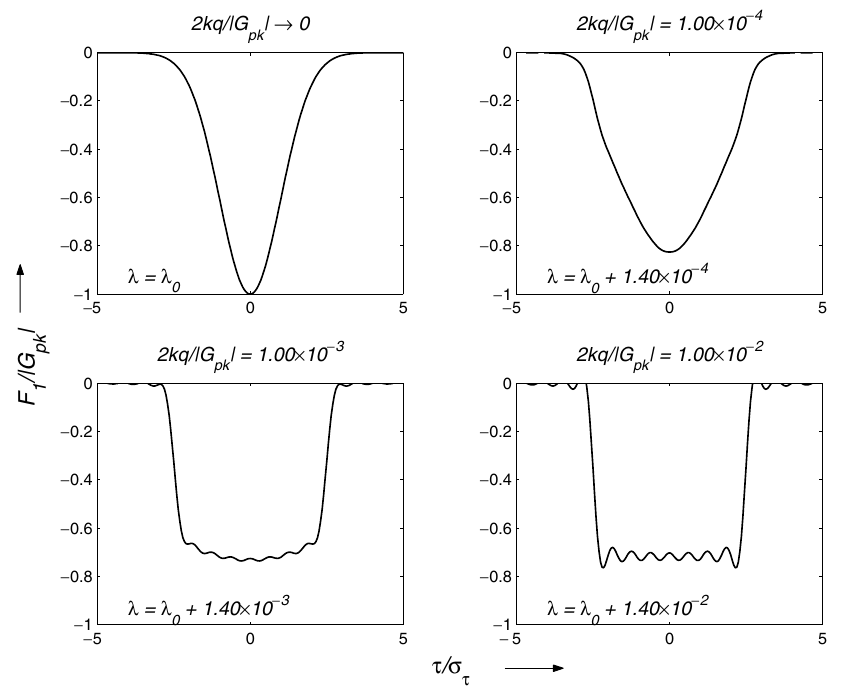
(cid:4) 2 =$ (cid:1) , p a (cid:24) m m